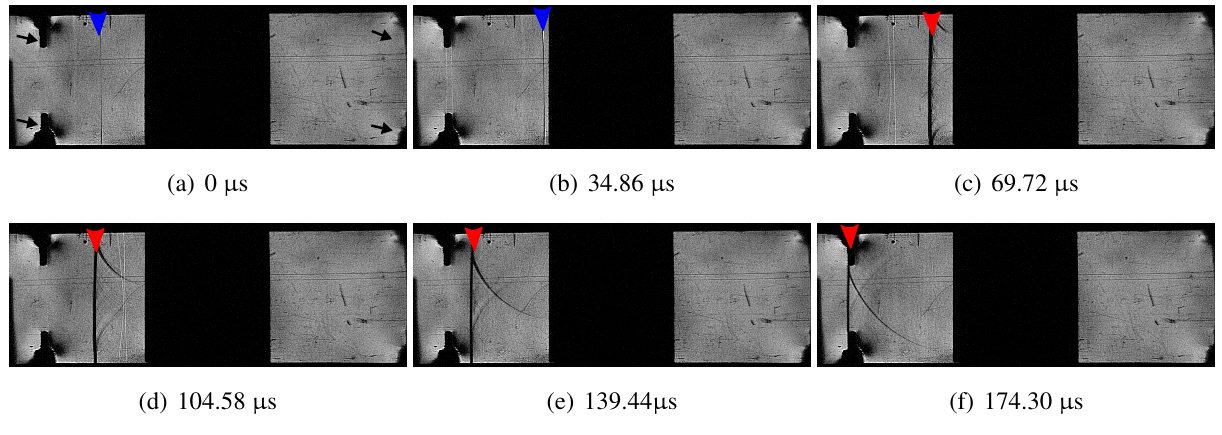
Figure 9. Open cell foam, Case